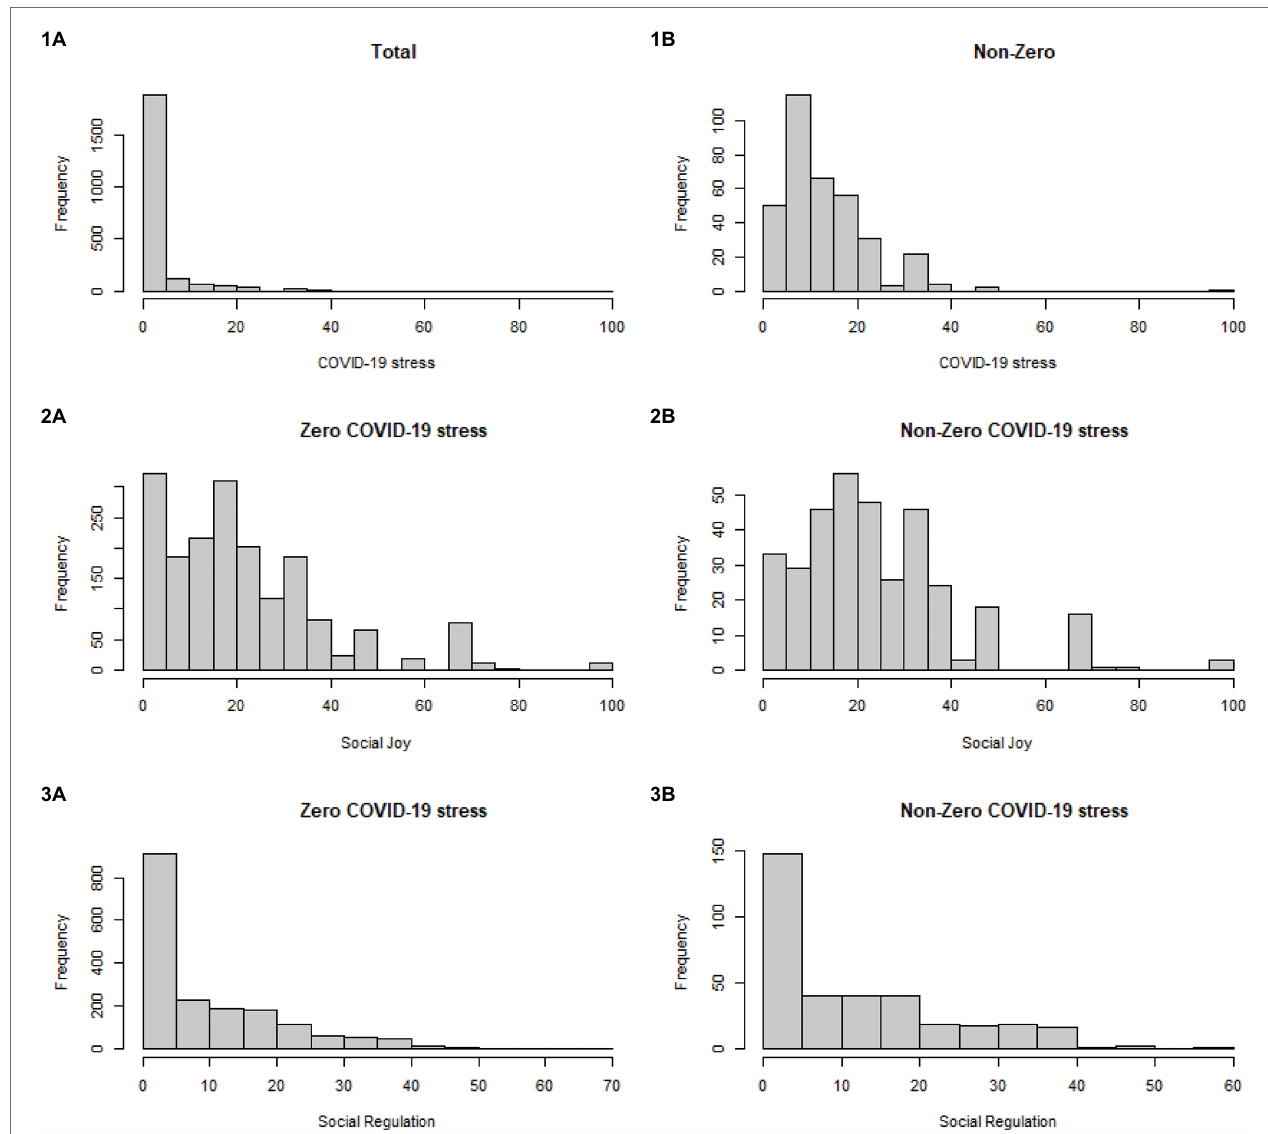
FIGURE 1 | Frequency Distributions of Study Variables. (1A) shows the total frequency distribution of COVID-19 stress. (1B) shows the frequency distribution of COVID-19 stress with zeros excluded. (2A) shows the frequency distribution of Social Joy for individuals who did not report COVID-19 stress. (2B) shows the frequency distribution of Social Joy for individuals who did report COVID-19 stress. (3A) shows the frequency distribution for Social Regulation for individuals who did not report COVID-19 stress. (3B) shows the frequency distribution for Social Regulations for individuals who did report COVID-19